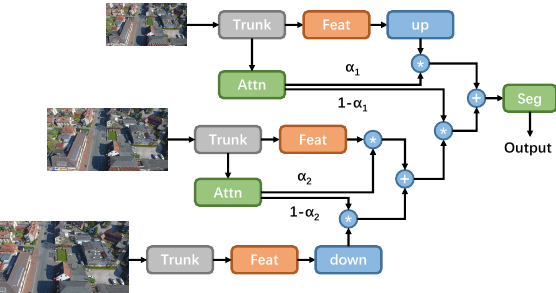
Figure 4. Architecture of the hierarchical multi-scale attention networks with feature level fusion. Segmentation head is moved to the end of the fused features. ⊕ , (cid:126) stand for element-wise addition and multiplication,